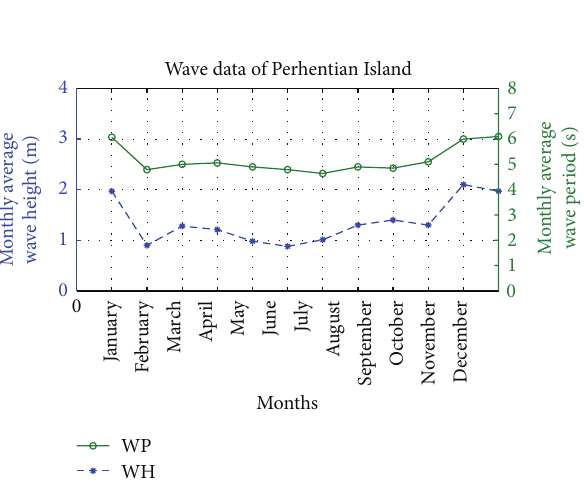
Figure 19: Monthly average WH/WP data of a year for Perhentian